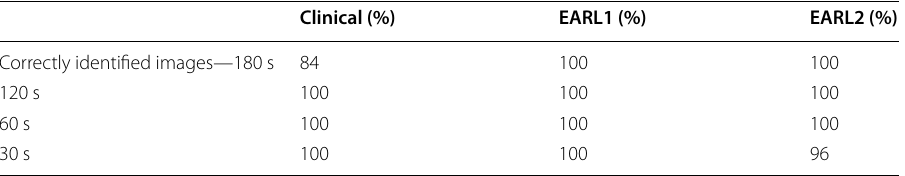
Table 4 Accuracy of the first CNN applied to data from the Siemens Biograph Vision which was not included in the training